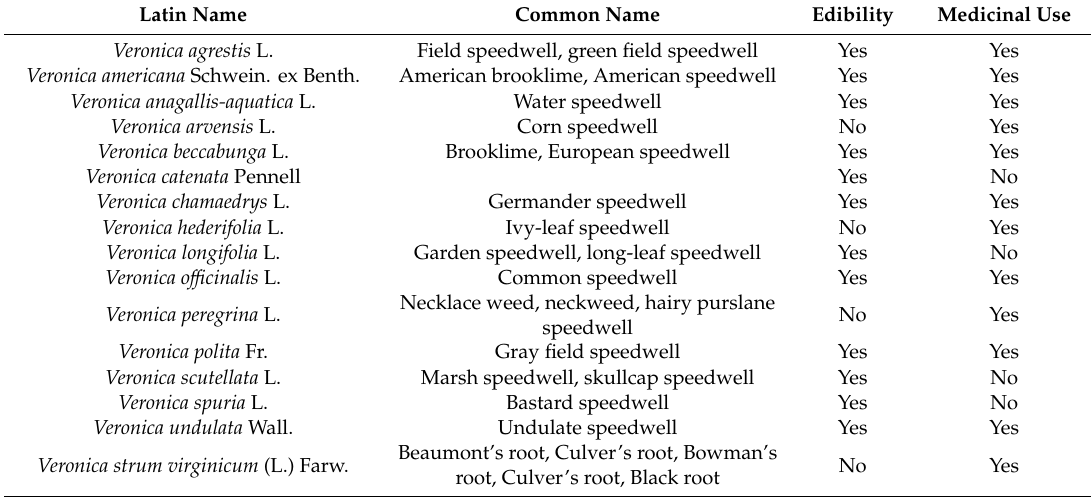
Table 1. List of some common Veronica species, their edibility, and medicinal uses